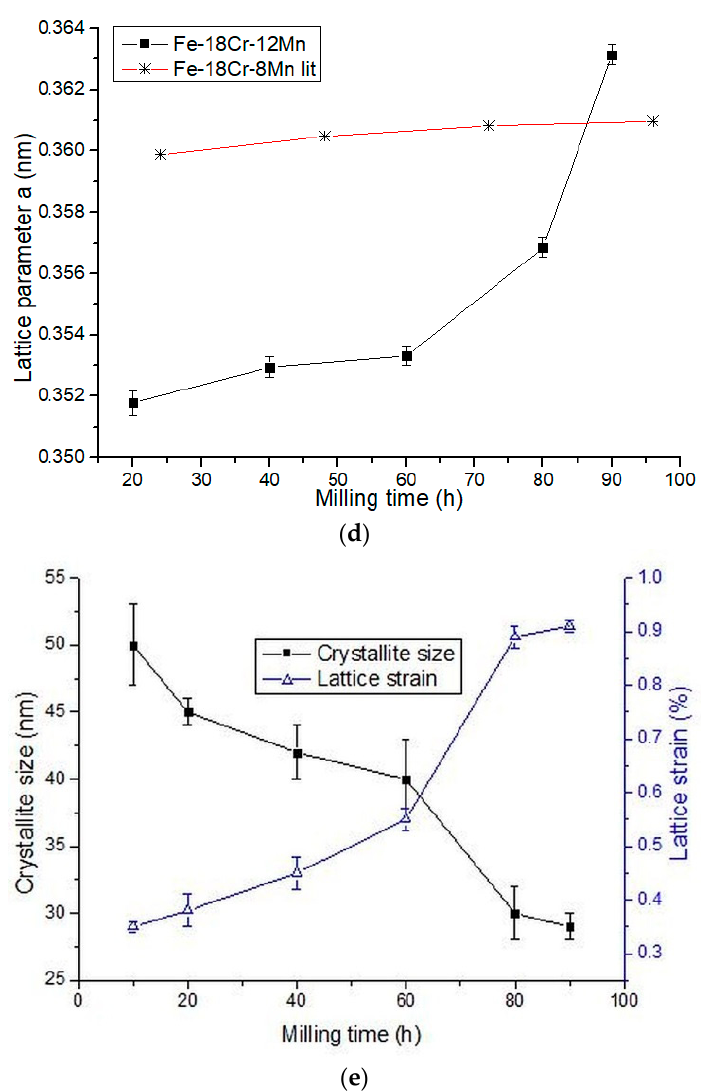
Figure 2. X-ray diffractometry (XRD) data of the Fe–18%Cr–12.8%Mn 4 N powders: ( a ) powders mixture in nitrogen for 1 h, ( b ) both powders mechanical alloying process (MA) in nitrogen and argon for 90 h, ( c ) MA for various milling times under nitrogen up to 90 h, ( d ) lattice parameter of the powder MA under nitrogen and the literature data for Fe–18%Cr–8%Mn powder (elemental powders of Fe, Cr, and Mn) MA under nitrogen [38], ( e ) crystallite size and lattice strain of as-milled powder under nitrogen atmosphere. Table 1. Internal lattice d-space and nitrogen content of the Fe–18%Cr–12%Mn powder and literature data for Fe–18%Cr–11%Mn elemental powders of Fe, Cr, and Mn ball milled in nitrogen. Milling Time (h)